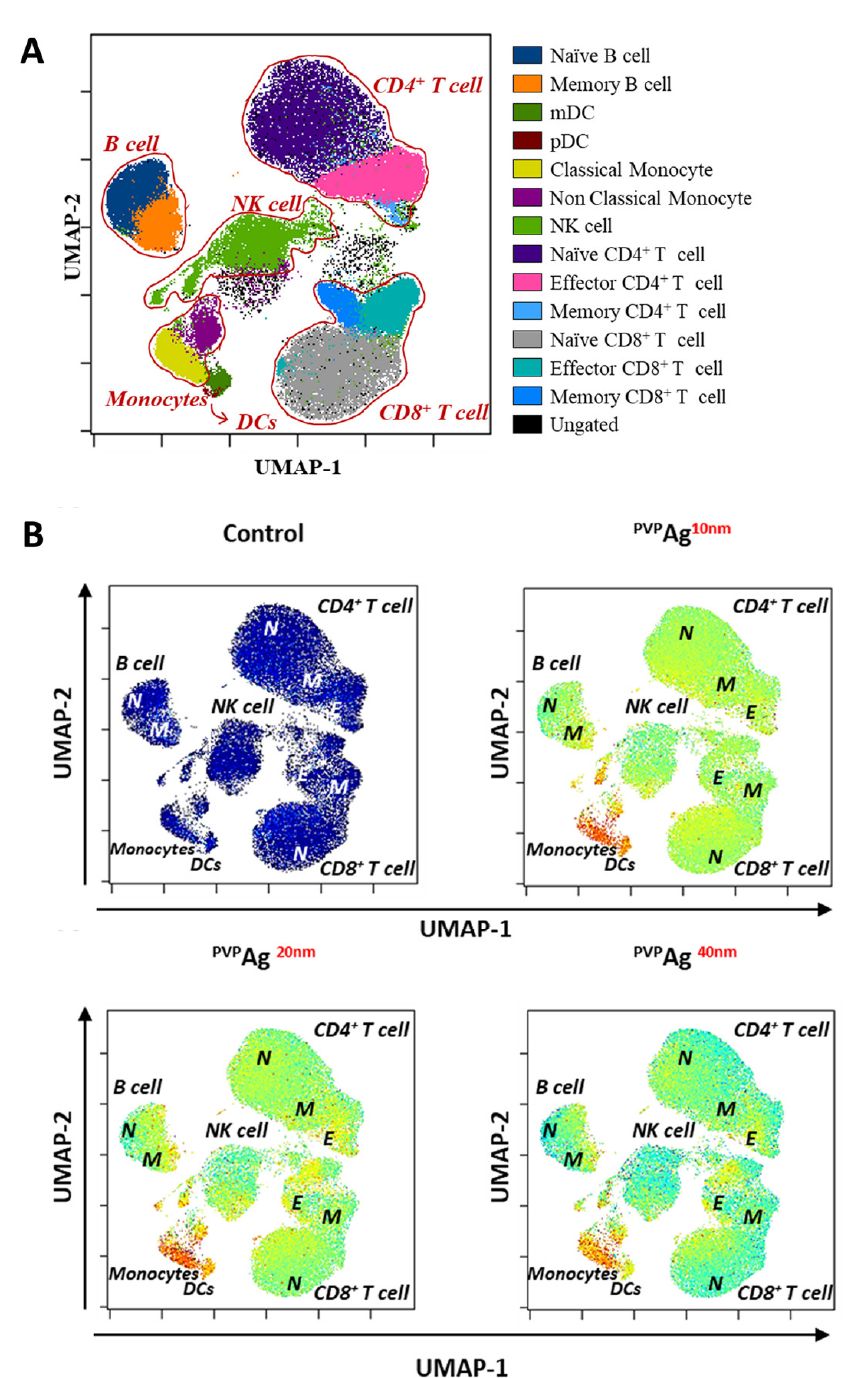
Figure 2. Manually gated cellular phenotypes. ( A ) Visualization of distinguished cellular types with manually gated islands; ( B ) Intensity of cellular interaction between PVP Ag 10 , PVP Ag 20 , and PVP Ag 40 Ag NPs and hPBMC overlaid on UMAP plots.